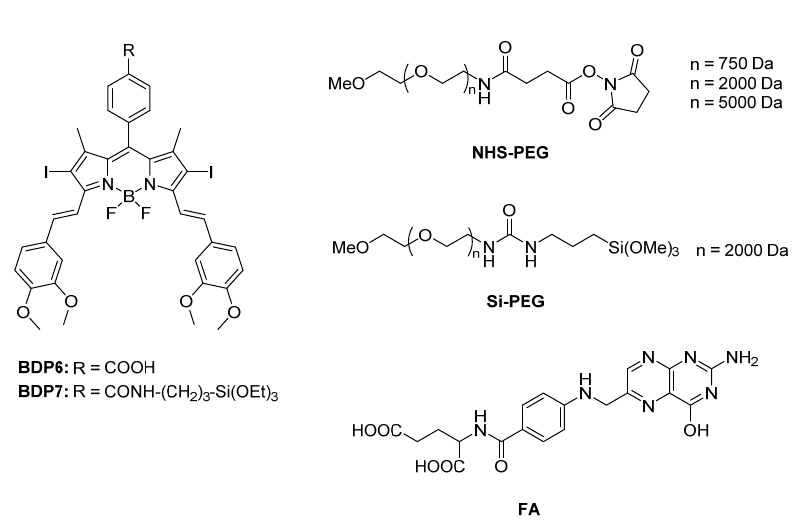
Figure 1. Molecular structure of the different compounds anchored to MSN: commercial (RB, Th, C6) and custom-made BODIPY photosensitizers (BDP1-BDP7), PEG derivatives with different functional groups (Si-PEG and NHS-PEG) and molecular weight (750 Da, 2000 Da and 5000 Da), and FA. Additionally, MSNs were externally coated with polyethylene glycol (PEG), as it is usually required to stabilize nanoparticle systems, enhance their life-time in the blood system and avoid the induction of immune responses [44,47,49,94–98]. For that, several PEG derivatives (Figure 1) with different graftable groups at one end of the chain (succin- imide group or with silyl group Si-PEG) were tethered at the MSN shell. The length of